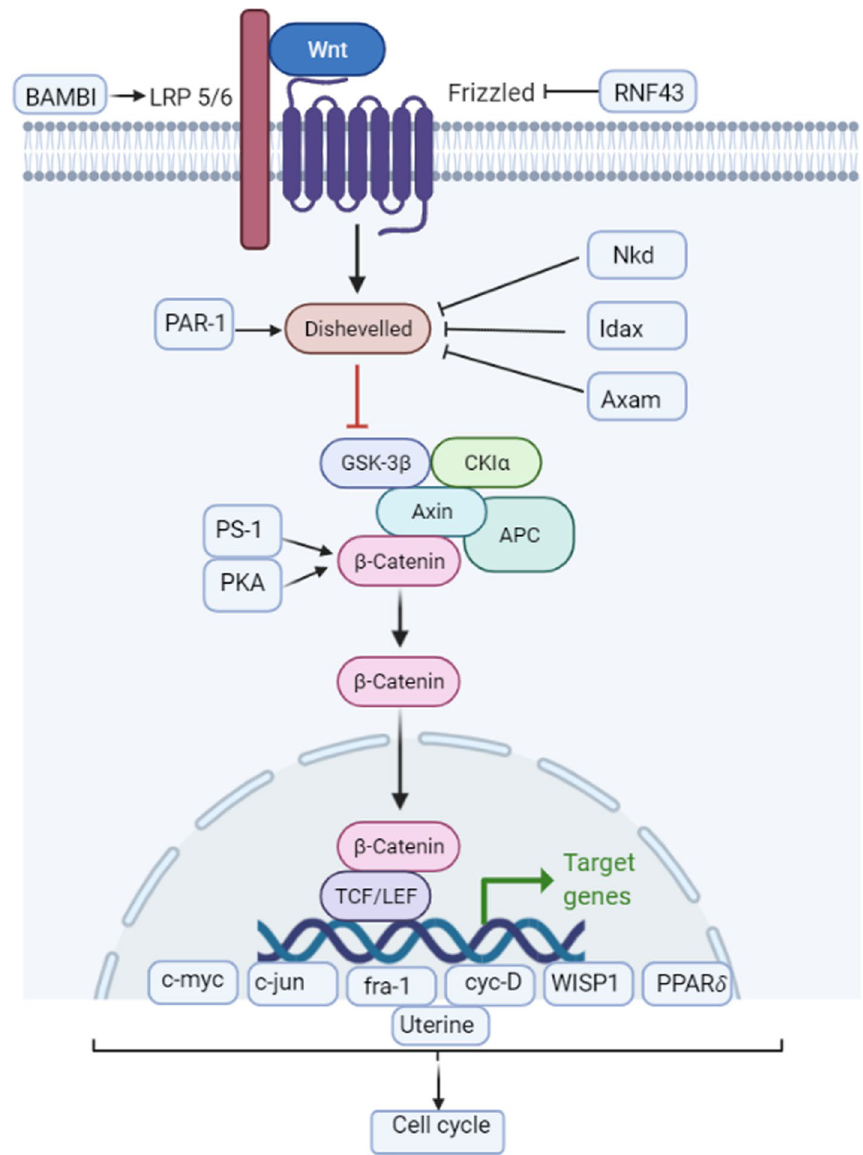
Fig. 2 Canonical Wnt/β- catenin pathway. Figure adapted from KEGG